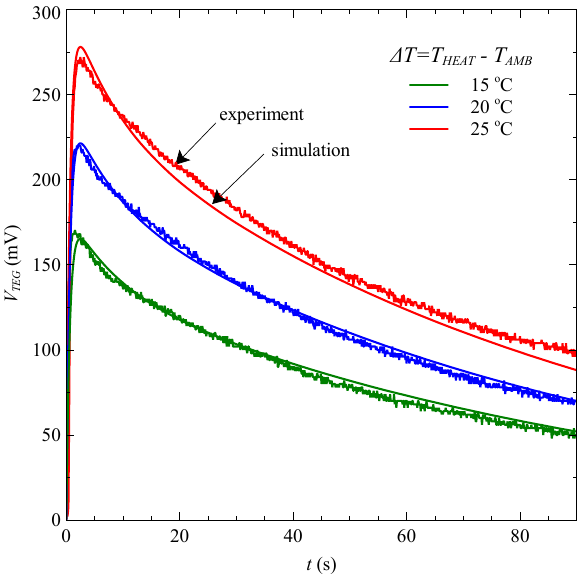
Figure 8. Generated voltage vs. time of the TEG1 with heatsink A for three temperature